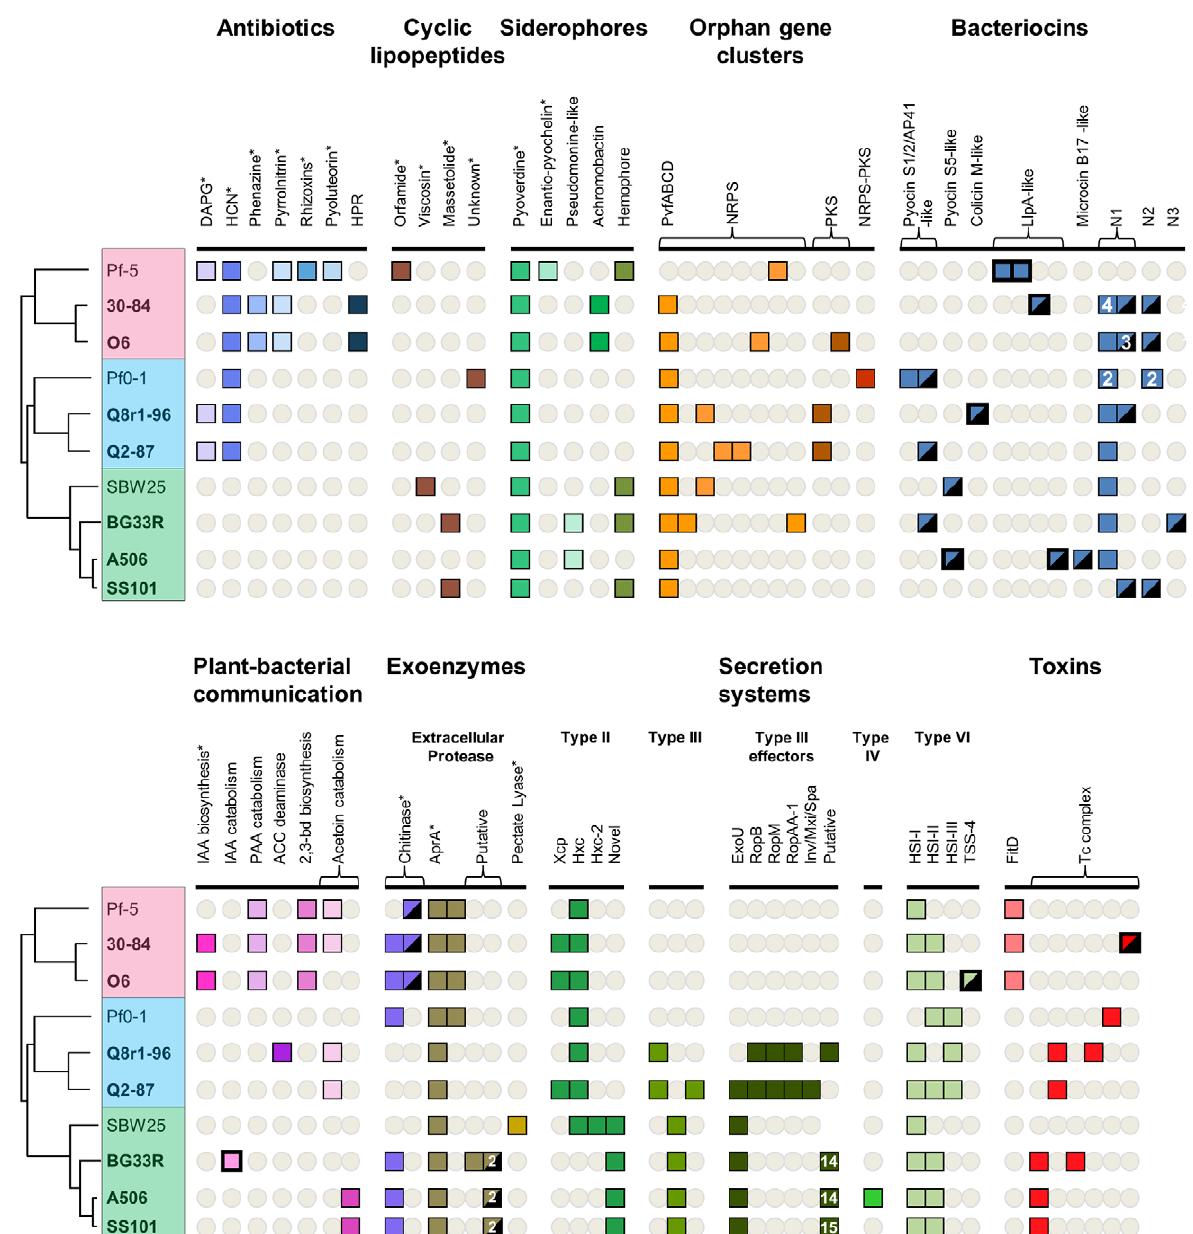
Figure 6. Selected biosynthetic/catabolic genes or gene clusters in the sequenced strains of the P.fluorescens group. Colored boxes represent the presence of a gene or gene cluster within a genome, while absence of a cluster is represented by a grey circle; numbers within a box represent the number of copies of a gene or cluster within a genome. Putative T3SS effectors were not examined for SBW25, therefore no box or circle is present in that column for SBW25. Genes within a mobile genetic element have the box outline bolded; genes within regions of atypical trinucleotide content have half of their boxes blackened. Plant-bacterial communication gene clusters are composed of: iaaMH (IAA biosynthesis); iacR , an ABC transporter, and iacHABICDEFG (IAA catabolism); paaCYBDFGHIJKWLN (PAA catabolism); acdS (ACC deaminase); budC/ydjL + ilvBN (2,3- butanediol biosynthesis); acoRABC + acoX + bdh (light pink, acetoin catabolism); acoRABC + budC (dark pink, acetoin catabolism). Abbreviations are as follows: 2,4-diacetylphloroglucinol (DAPG); hydrogen cyanide (HCN); derivatives of rhizoxin (Rhizoxins); 2-hexyl-5-propyl-alkylresorcinol (HPR); non- ribosomal peptide synthetase (NRPS); polyketide synthase (PKS); novel groups 1–3, respectively, of the carocin- and pyocin-like bacteriocins found in these strains (N1, N2, N3); indole-3-acetic acid (IAA); phenylacetic acid (PAA); aminocyclopropane-1-carboxylic acid (ACC); type VI secretion systems found within virulence loci HSI-I, HSI-II, and HSI-III, respectively, of P. aeruginosa (HSI-I, II, II); TSS-4 from Burkholderia pseudomallei (TSS-4). Asterisks indicate that the expected phenotype is known to be expressed or was detected in this study by the strains having the indicated genes or gene clusters. doi:10.1371/journal.pgen.1002784.g006 to the characterized 2-hexyl-5-propyl-alkylresorcinol biosynthesis alkylresorcinol exhibits moderate antifungal and antibacterial activity gene cluster of Pseudomonas chlororaphis subsp. aurantiaca BL915 [56] and, if produced by P. chlororaphis O6 and 30-84, could contribute to was identified in the two P. chlororaphis genomes. 2-hexyl-5-propyl- their suppression of fungal and bacterial plant pathogens.